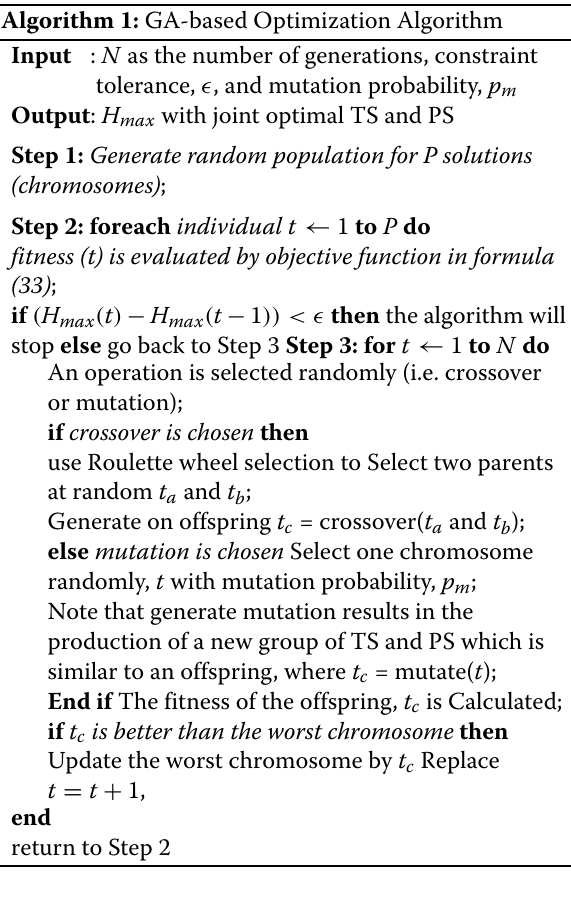
Algorithm 1: GA-based Optimization Algorithm